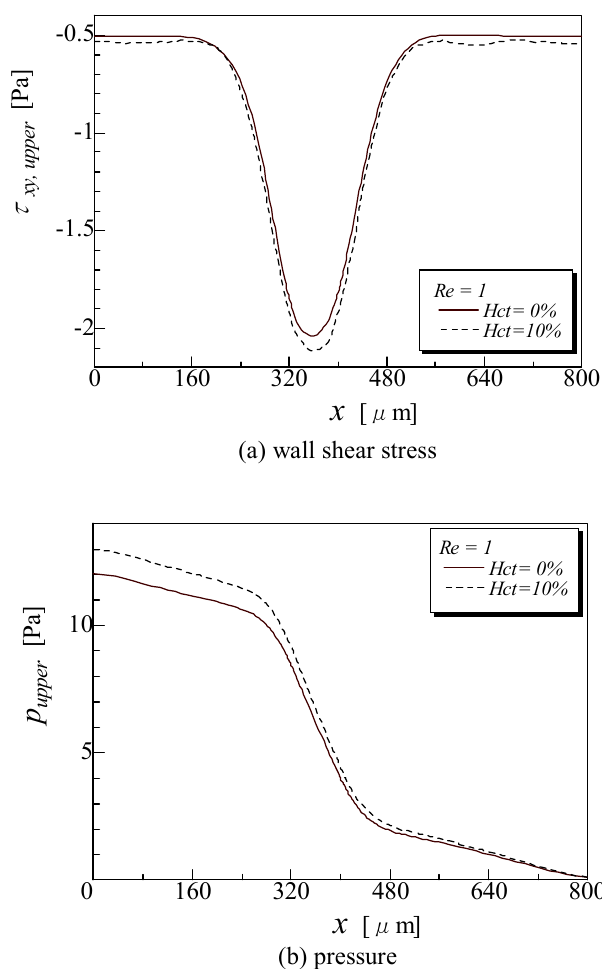
Fig.5 Effect of Hct on the wall shear stress and the pressure on the upper wall